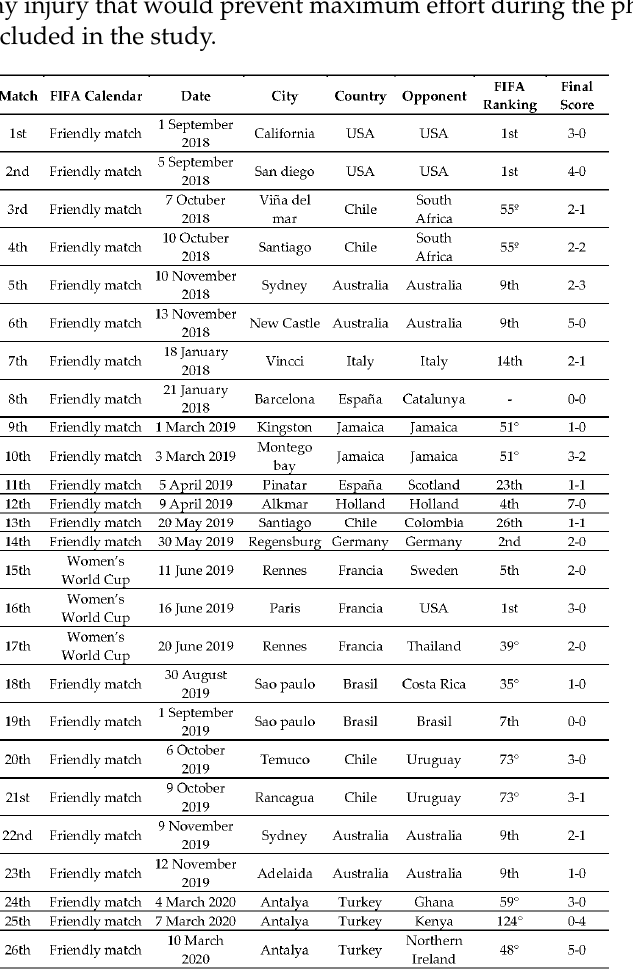
Figure 2. Official FIFA and France 2019 World Cup match schedule analyzed for the study.